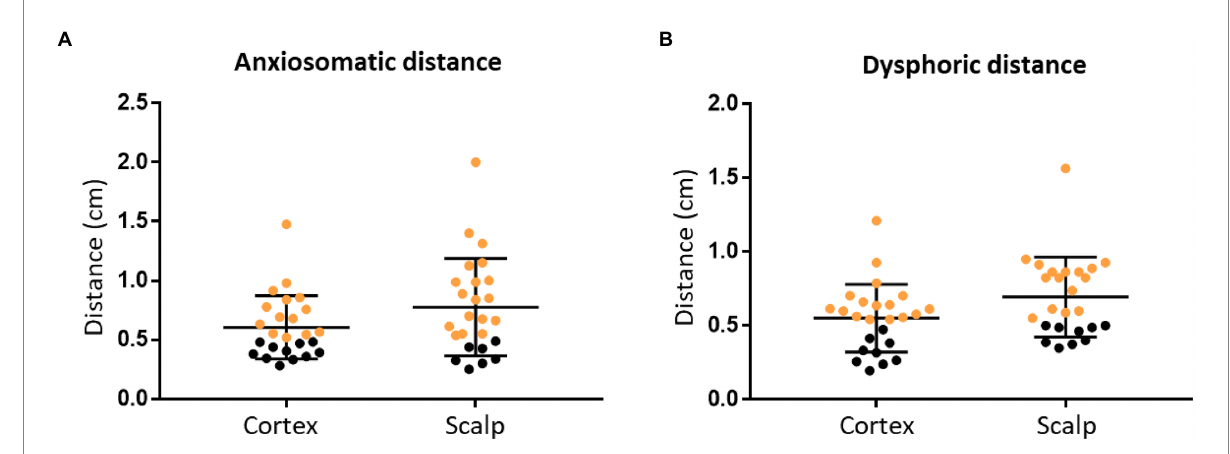
FIGURE 3 The personalized and landmark-based target distance of the two targets. Target distance of the anxiosomatic targets (A) and dysphoric targets (B) , respectively, on the cortex and scalp. The personalized and landmark-based target distances greater than 5 mm are marked in orange.